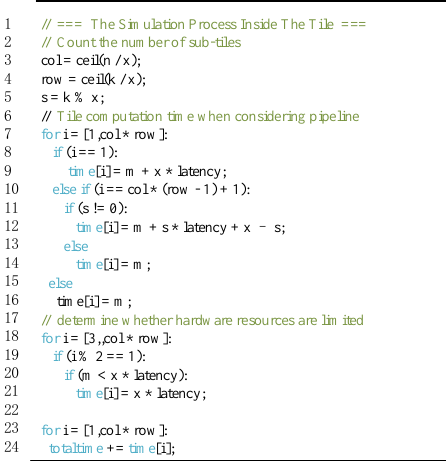
Figure 6. The simulation process inside the tile.